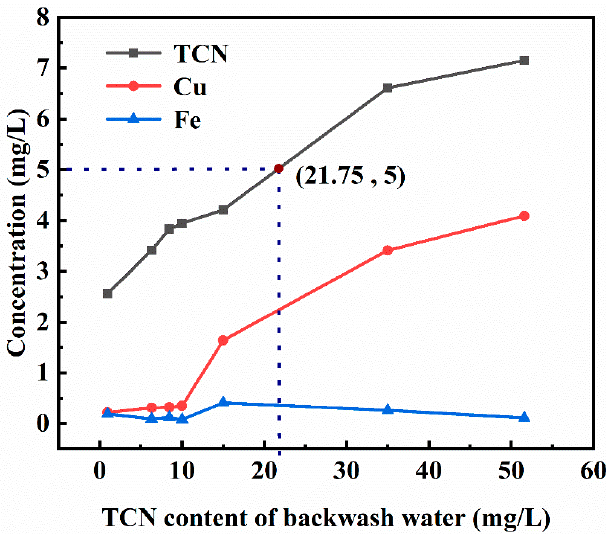
Figure 5. Effect of the TCN content in the backwash water on the leaching toxicity of backwashed cyanide tailings. cyanide